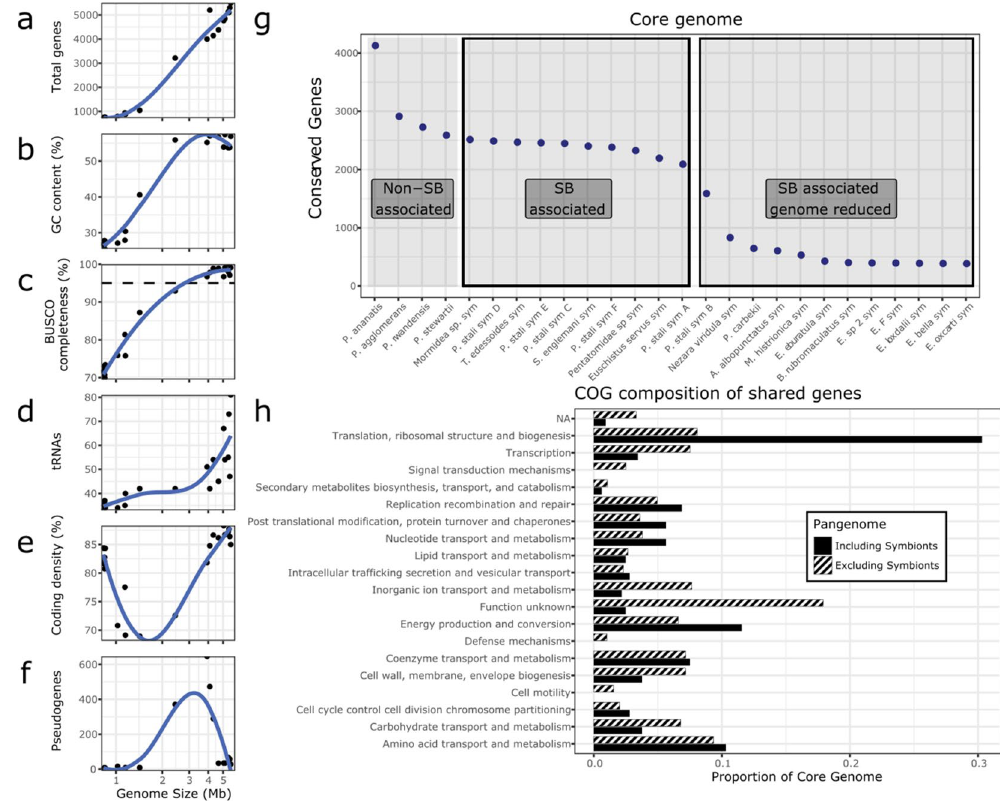
Figure 1. Genomic characteristics of pentatomid symbionts. ( a – f ) Genomic characteristics as a function of genome size for stink bug symbionts. ( a ) number of genes annotated, ( b ) GC % of the entire genome, ( c ) percentage of conserved genes found according to the BUSCO gammaproteobacterial set (Dotted line in indicates the recommended 95% threshold of BUSCO completeness for new species descriptions). ( d ) tRNAs annotated, ( e ) coding density of the genome, ( f ) number of pseudogenes annotated by Prokka. Blue line indicates the LOWESS fitted curve. ( g ) Number of conserved genes between each genome and all larger genomes (excluding pseudogenes). ( h ) COG composition of the shared genes for non-symbiotic and large genome symbionts (> 3.8 Mb, dashed bar) and for all genomes including genome reduced symbionts (< 1.4 Mb, solid